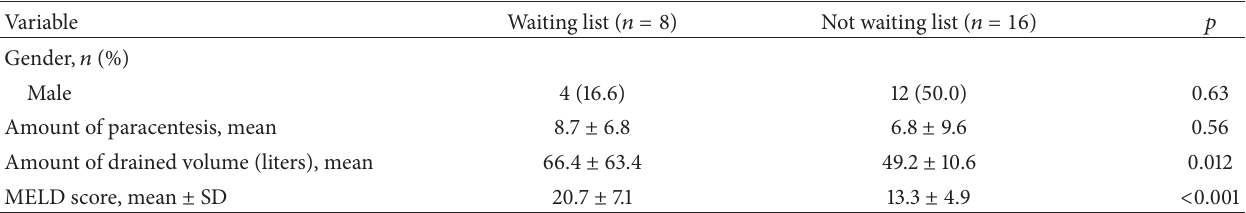
Table 4: Comparison of spontaneous bacterial peritonitis in cirrhotic patients list and not list for liver transplant. Variable Waiting list ( 𝑛 = 8